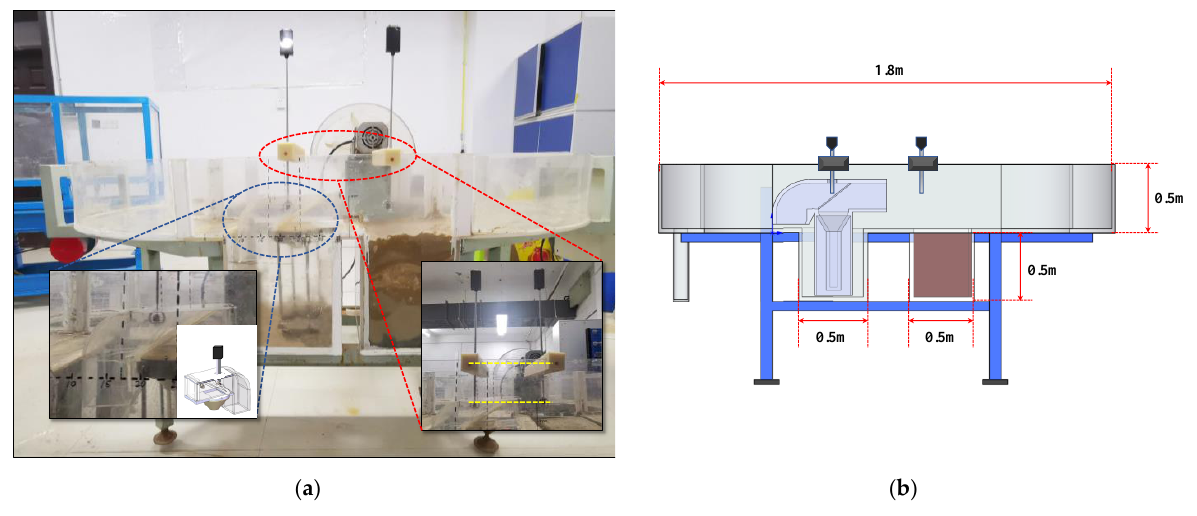
Figure 7. ( a ) Field test chart; ( b ) Test schematic.